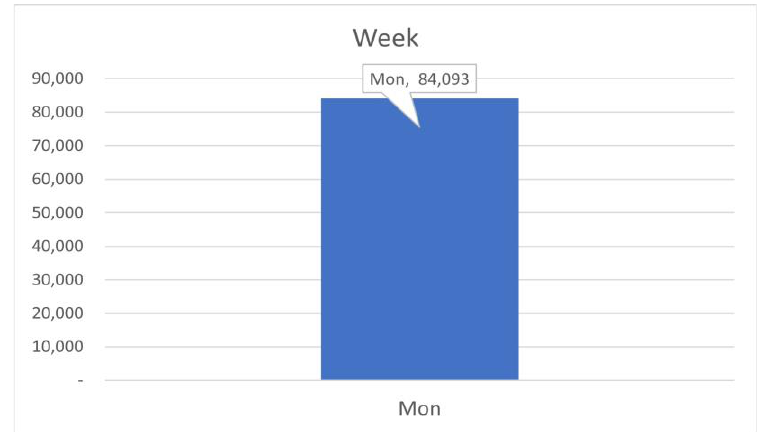
Figure 14. Traffic per day.